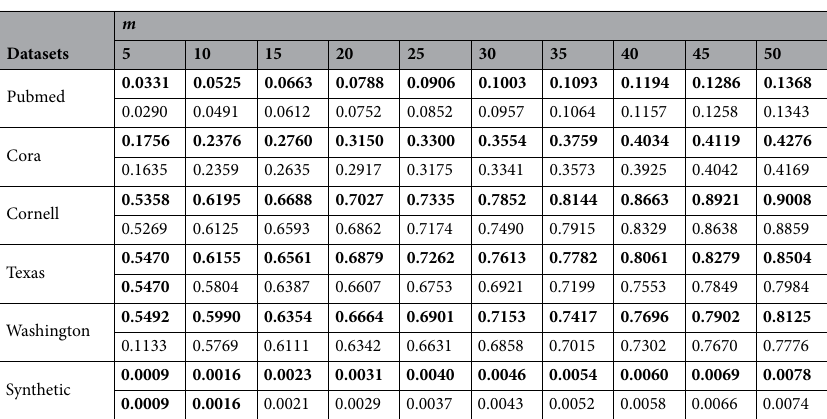
Table 2. Ablation experiments that analyze the impact of recalculating the INF of seed nodes’ in-neighbors. The propagation is simulated on the LTPlus model and the number of seed nodes m changes from 5 to 50. The first and second row of each dataset is the influence spread of our method with/without recalulating INF of seed node’s in-neighbors, respectively. Significant values are in bold.